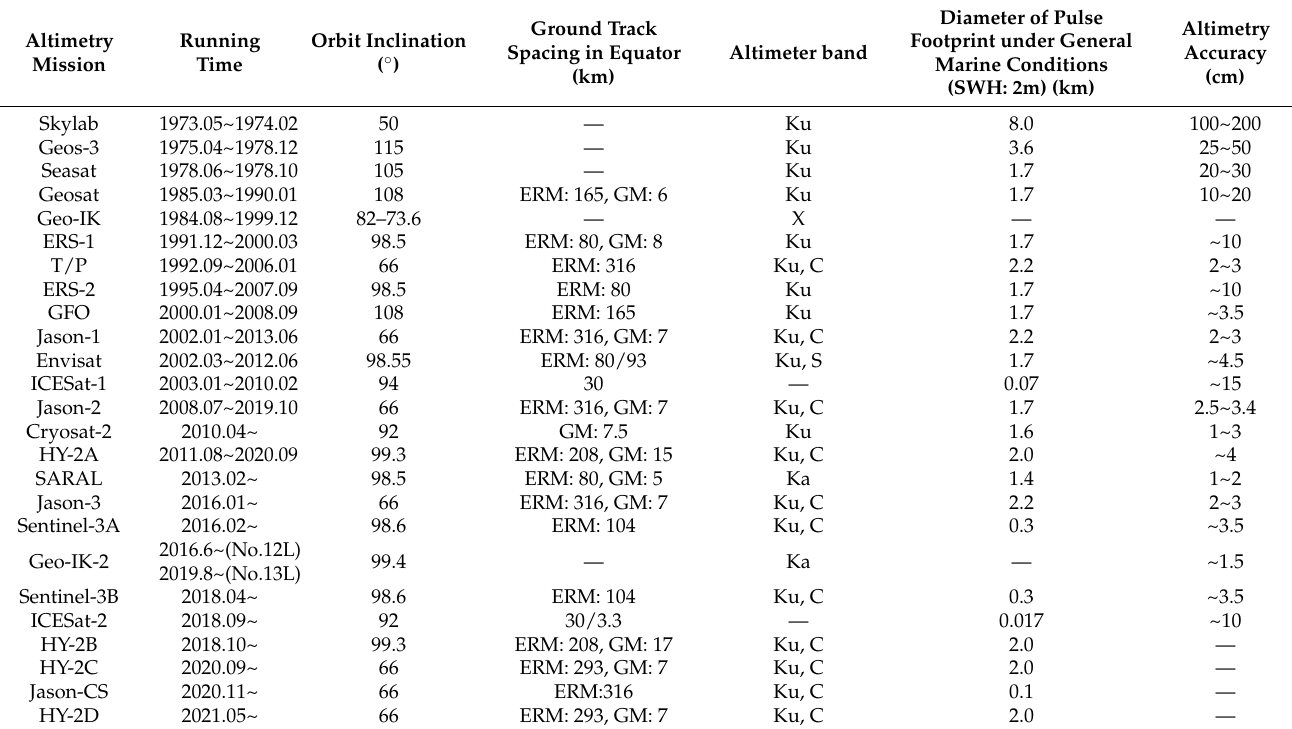
Table A1. The main satellite altimeter